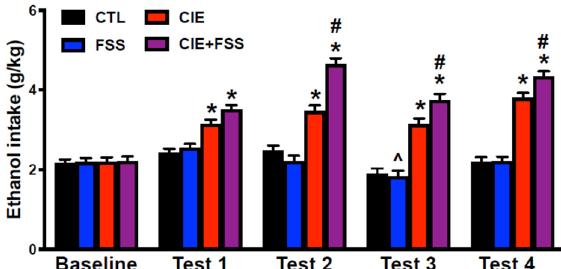
Figure 3. Ethanol intake in g / kg during the baseline and each test cycle after CIE or air exposure for the CTL, FSS, CIE, and CIE + FSS groups. CIE and CIE + FSS mice showed a significantly higher level of voluntary ethanol intake when compared to CTL mice and their own baseline (*). Mice in the FSS group drank less ethanol during Test 3 compared to their own baseline. Mice in the CIE + FSS group consumed the most ethanol compared to all the other groups during Test Cycles 2–4 (#).